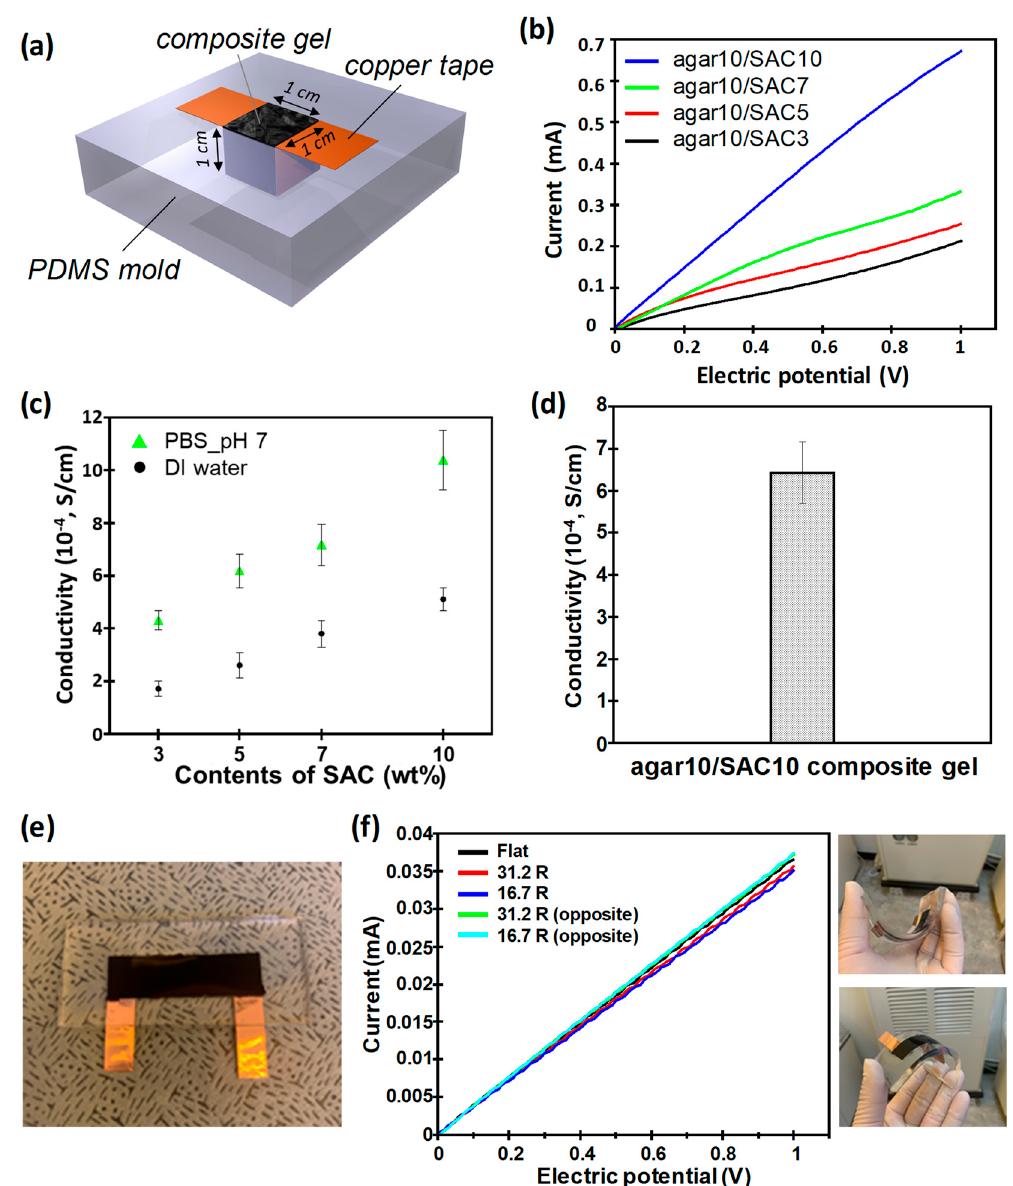
Figure 4. ( a ) Schematic diagram of the cubic agar/SAC composite gels in a poly(dimethylsiloxane) (PDMS) mold connected with copper taps for conducting the current–voltage (I–V) measurements. ( b ) I–V measurement of the agar/SAC composite gel prepared with various SAC contents: 10 wt % (blue), 7 wt % (green), 5 wt % (red), or 3 wt % (black) in 10 wt % agar. ( c ) The conductivity of the agar/SAC composite gel prepared with deionized (DI) water (black dot) or phosphate buffer saline (PBS) buffer (green triangle), as a function of the SAC content. ( d ) Average conductivity of recycled agar10/SAC10 composite gels. ( e ) Photo of agar/SAC composite gel integrated in flexible PDMS. ( f ) I–V measurement (left panel) and photos (right panel) of bended agar/SAC composite gel. The gel was bent in both directions with a curvature of 31.2 R (red, green) and 16.7 R (blue, cyan), respectively.